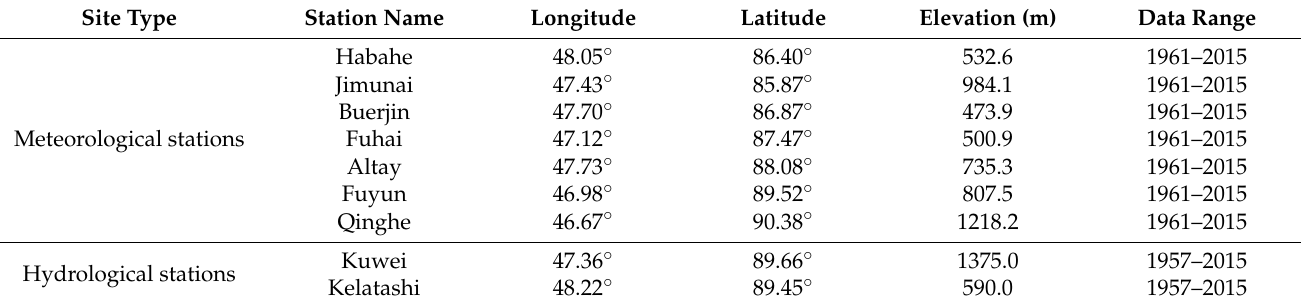
Table 1. Information of meteorological and hydrological stations used in this